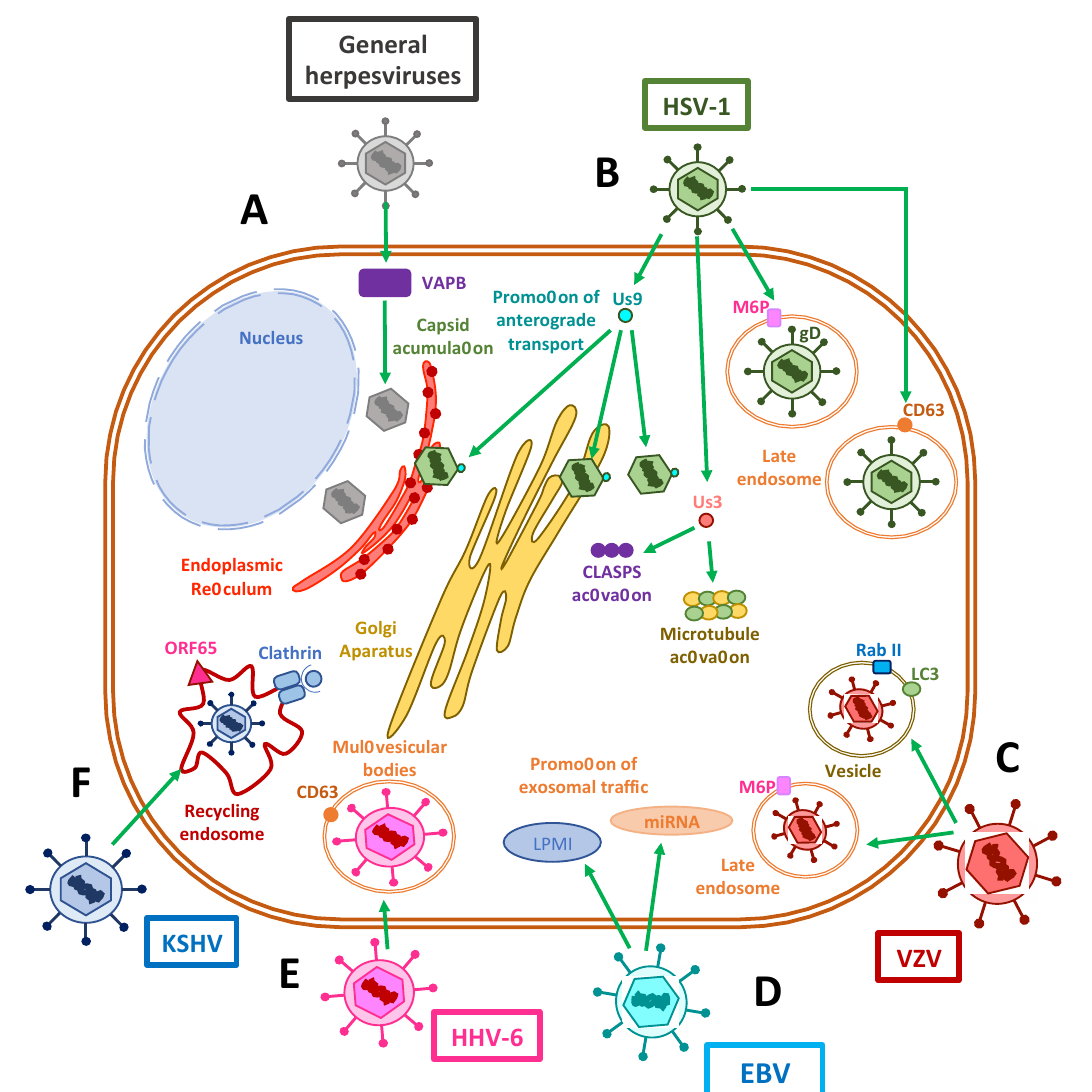
Figure 4. Exocytosis vesicles participate in herpesvirus exit. ( A ) The accumulation of herpesvirus capsids in the cytoplasm has been shown to be assisted by VAPB host proteins. ( B ) The HSV-1 Us9 protein interacts with capsids in the endoplasmic reticulum (ER), the Golgi apparatus and the cytosol in order to promote the anterograde transport of viral components through microtubules. Us3 protein has also been shown to stabilize and activate microtubules and CLASP complexes to promote vesicle transport. The interactions of viral gD with host M6P and its receptors promote the export of virus-containing late endosomes. On the other hand, viral proteins have been shown to co-localize with CD63 or CD63 and MHC-II, suggesting a potential immune-modulatory role for late endosomal trafficking. ( C ) VZV has been reported to use M6P and its receptors to promote viral export. Additionally, this virus appears to be exocytosed in single-membrane vesicles from the autophagosomal pathway, which contain LC-3 and Rab II. ( D ) EBV shuttles LPMI- and miRNA-containing vesicles derived in exosomal traffic modulation. ( E ) Exit of HHV-6 occurs through the exosomal pathway, using multivesicular bodies (MVBs). ( F ) Finally, KSHV recycles clathrin-coated endosomal vesicles, used during cell entry, for viral exit using the viral protein